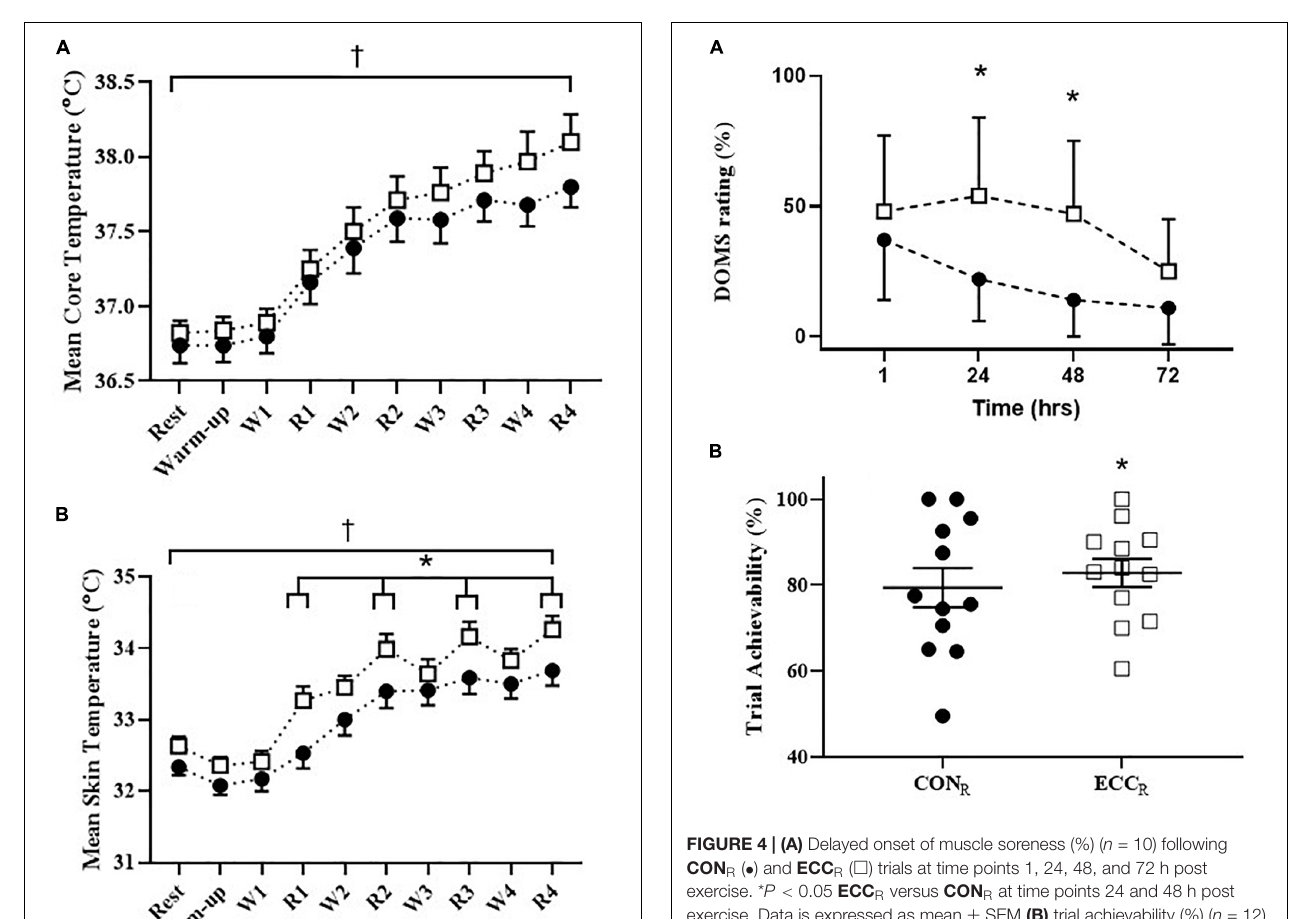
94 ± 1%, P > 0.05). Rating of perceived exertion for whole body ( CON R : 10 ± 0; ECC R : 11 ± 0, P > 0.05), chest ( CON R : 10 ± 0; ECC R : 10 ± 0, P > 0.05) and legs ( CON R : 11 ± 0; ECC R : 12 ± 0, P > 0.05) were equivalent between concentric and eccentric recovery periods.